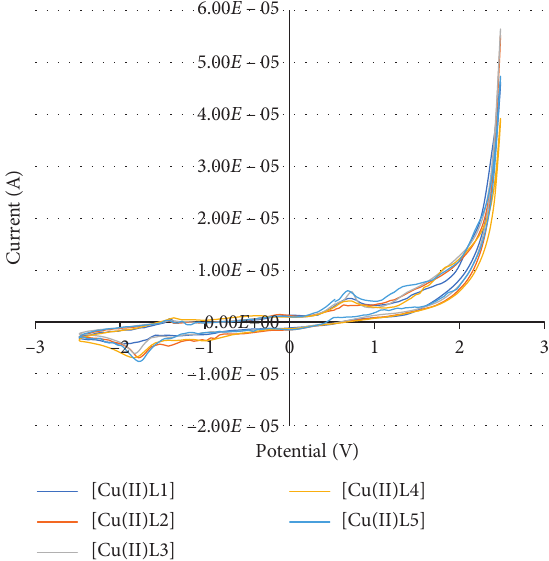
Figure 4: Cyclic voltammograms of unsymmetrical tetradentate Schiff base Cu(II)